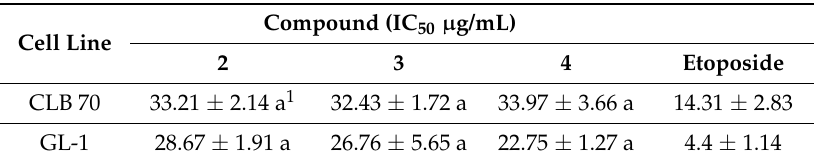
Table 2. The antiproliferative activity of hydroxylactones 2 , 3 , 4 and control – Etoposide against the selected cancer cell lines expressed as IC 50